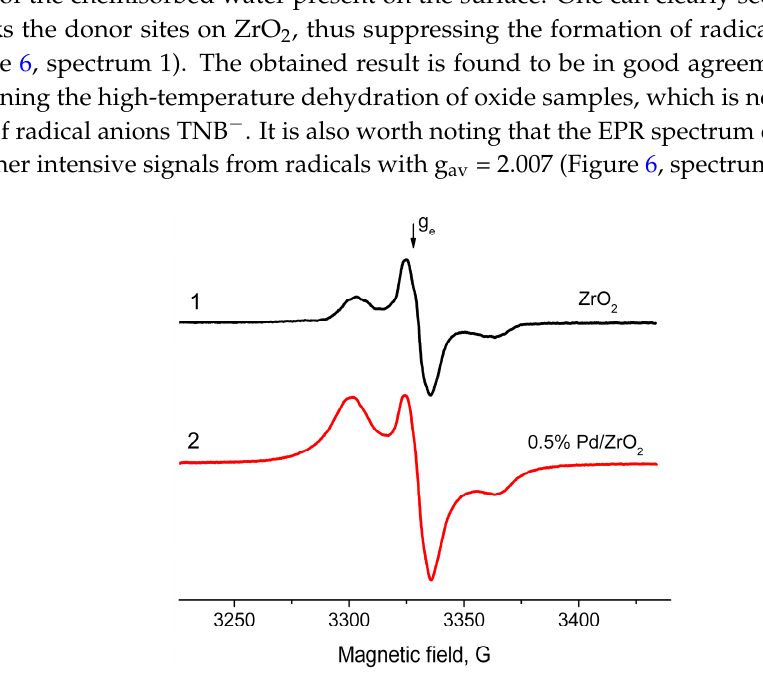
Figure 5. Electron paramagnetic resonance spectra of radical anions emerged after adsorption of 1,3,5-trinitrobenzene from its 2 × 10 − 2 M solution in toluene on surface of ZrO 2 ( 1 ) and 0.5% Pd/ZrO 2 ( 2 ) catalyst. T act = 500 °C.